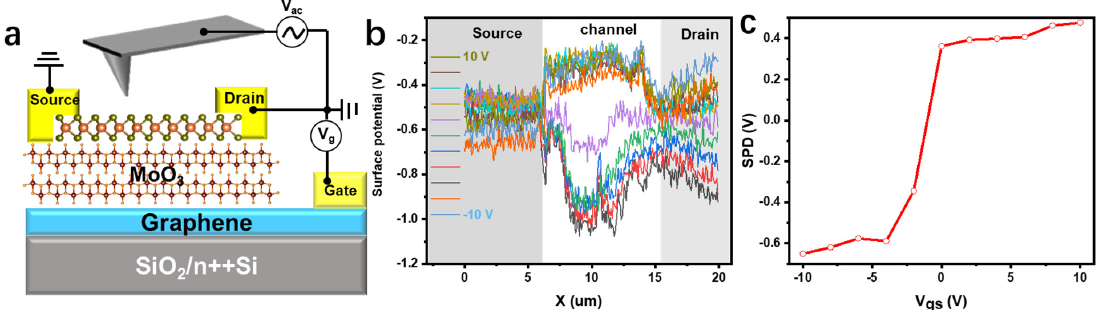
Figure 4. ( a ) Schematic diagram of KPFM test structure. ( b ) Surface potential diagram at different gate voltages, the interval is 2 V. ( c ) Summary diagram of contact potential difference between electrode and MoS 2 under different gate voltages.